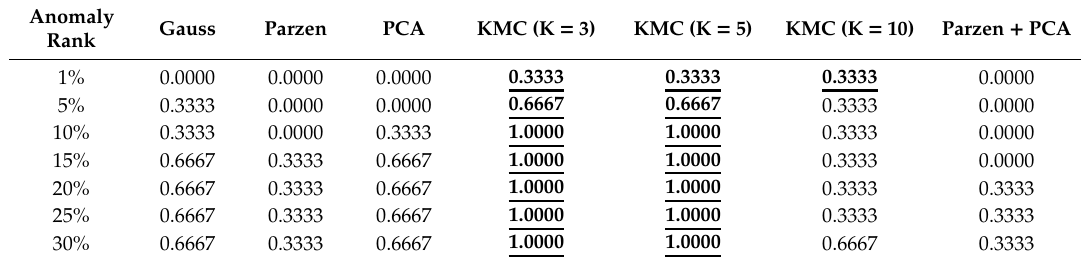
Table 18. True detection rate of each anomaly detection algorithm based on the e-mail communication network dataset (DNS1758). Best performance is shown in bold and underlined (number of normal behaviors in the test set: 498, number of malicious behaviors in the test set: